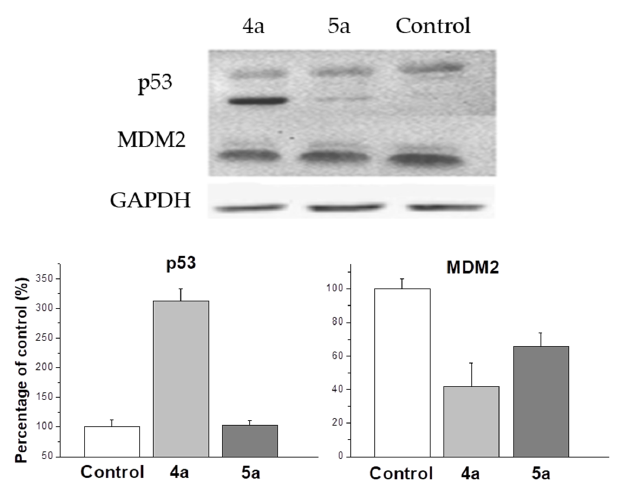
Figure 6. Changes in the relative expression levels of p53 and MDM2 proteins in HeLa cells under the treatment with compounds 4a and 5a (at concentration 10 μ